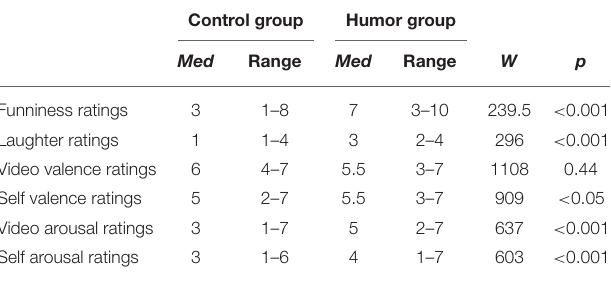
TABLE 4 | Group characteristics with respect to mood manipulation.